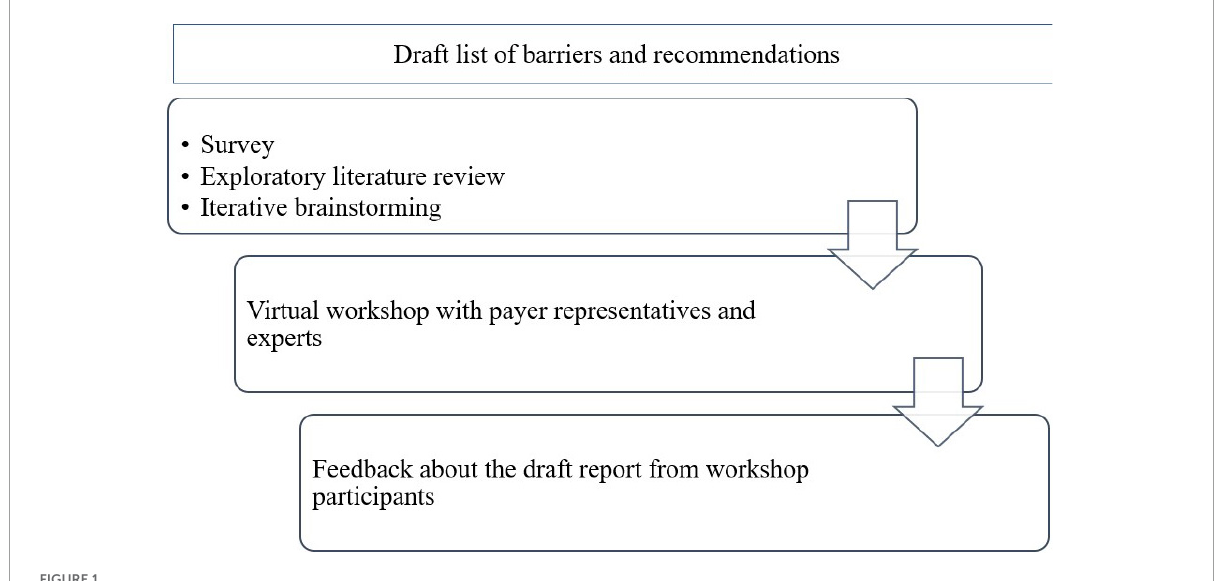
FIGURE1 Process of creating policy recommendations for the implementation of outcome-based reimbursement models for technologies with high upfront cost in Central and Eastern European and Middle Eastern countries.